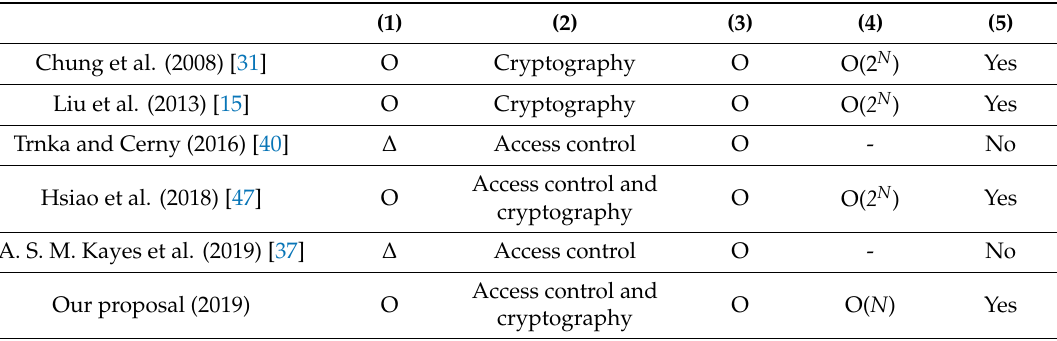
Table 9. Comparison with security